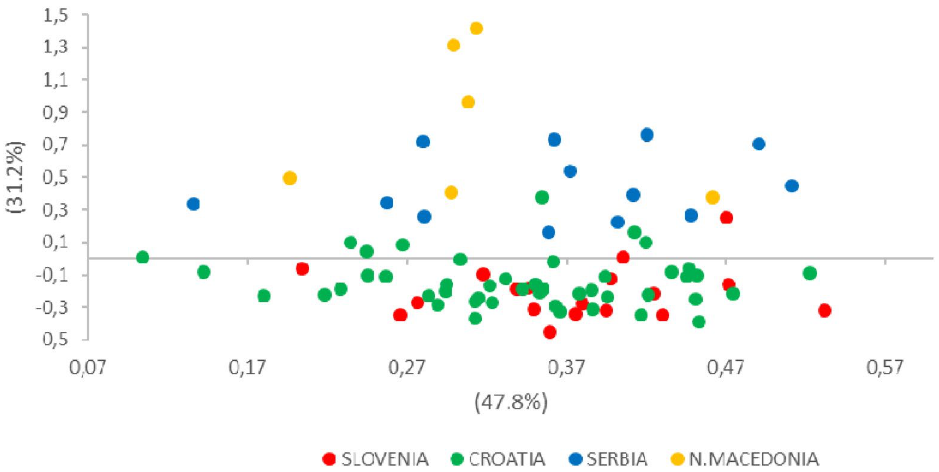
Figure 3. A two-dimensional plot of the FCA performed using GENETIX. European wildcats from different populations are indicated by different colours. The first axis explained 47.8% ( P = 0.010), and the second explained 31.2% ( P = 0.072) of the